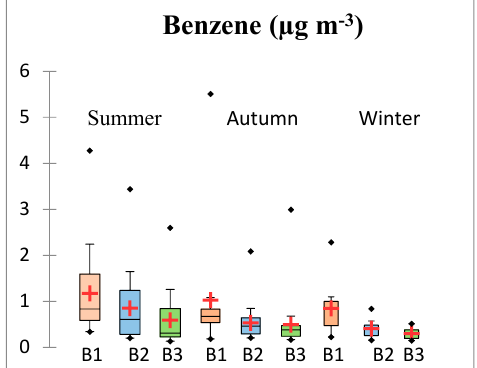
Figure 2. Diurnal, seasonal variation and parametric statistics for benzene in the study site. B1: morning sampling period (09:00–10:30 h); B2: midday sampling period (12:00–13:30 h); and B3: afternoon sampling period (15:00–16:30 h). The red crosses correspond to the means. The central horizontal bars are the medians. The lower and upper limits of the box are the first and third quartiles, respectively. The points are the minimum and maximum values for each station. The horizontal width of the box has no statistical significance; it is only for better